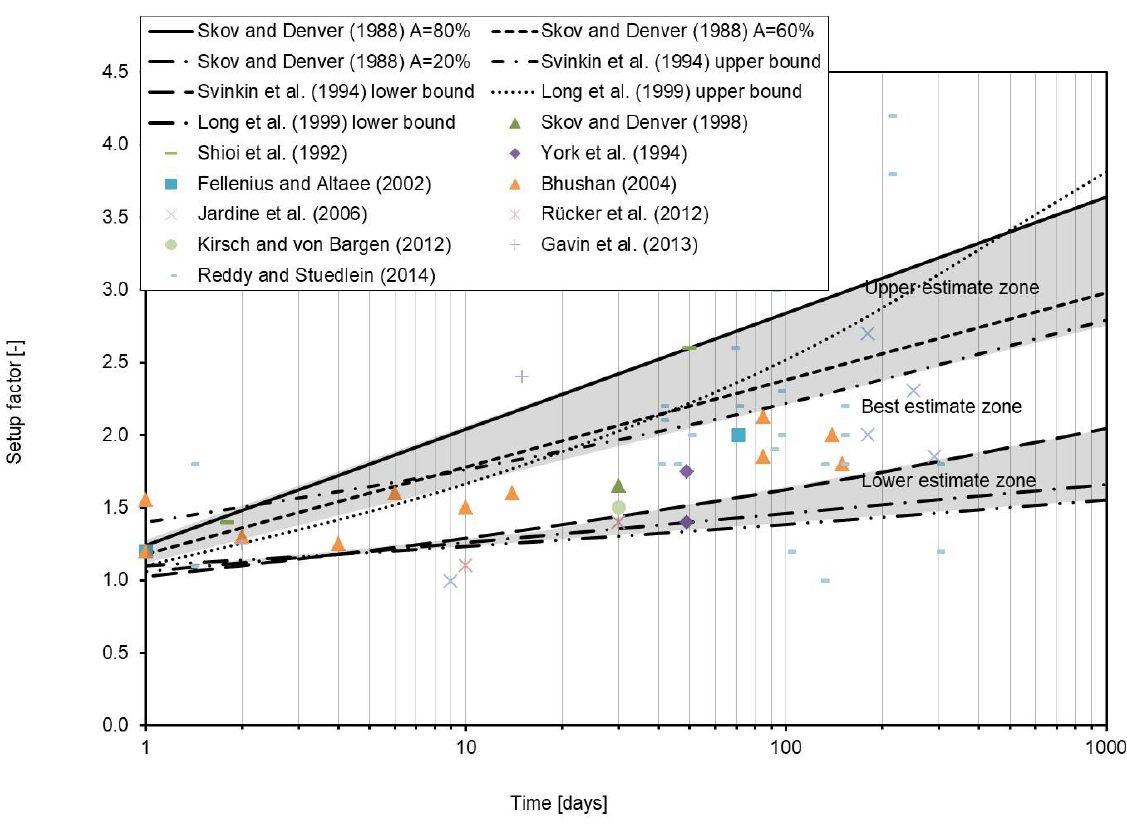
Figure 3 . Compilation of pile cases history in predominately sand layer Figure 3 : Compilation of pile cases history in predominately sand